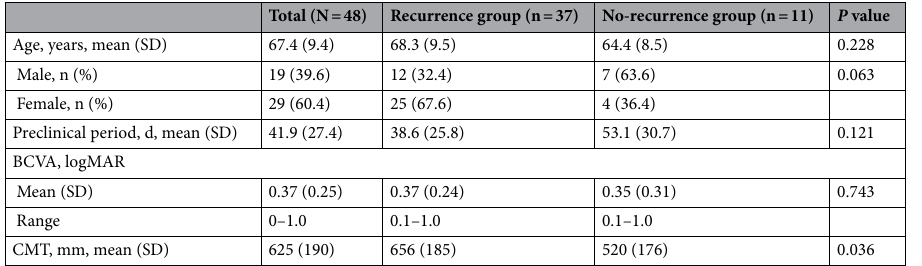
Table 1. Characteristics of patients with untreated macular oedema due to branch retinal vein occlusion before starting treatment with intravitreal injections of the anti-vascular endothelial growth factor agent